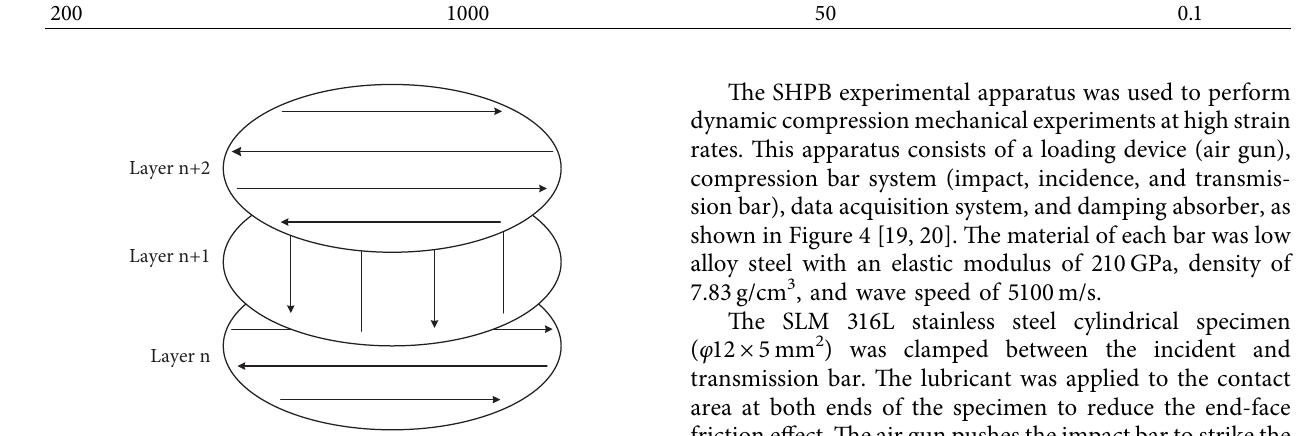
Figure 2: Schematics representing the alternating stripes scanning strategy. Table 3: The heat treatment process of 316L stainless steel pro- duced via SLM.